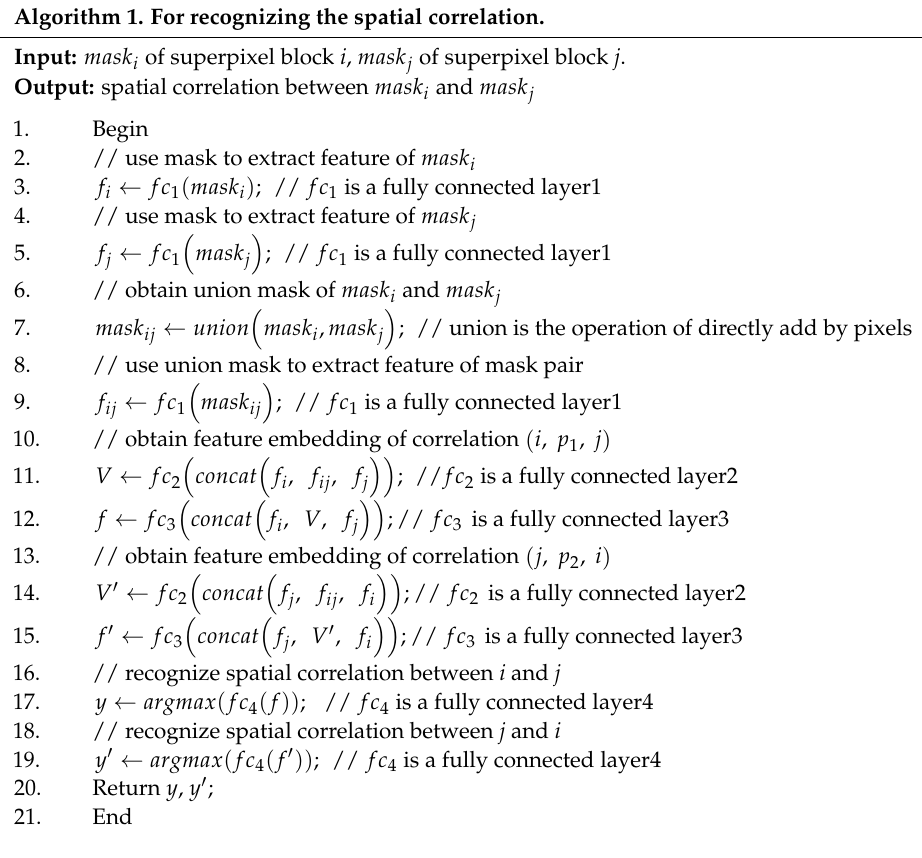
Figure 9. The framework of spatial correlation recognition module. The input of this module is pairs of masks, and the output is the recognized spatial correlation between masks. The fc k (k = 1, 2, 3, 4) represent different fully connected layers. C represents the concatenation operator to concatenate tensors in a specific axis.